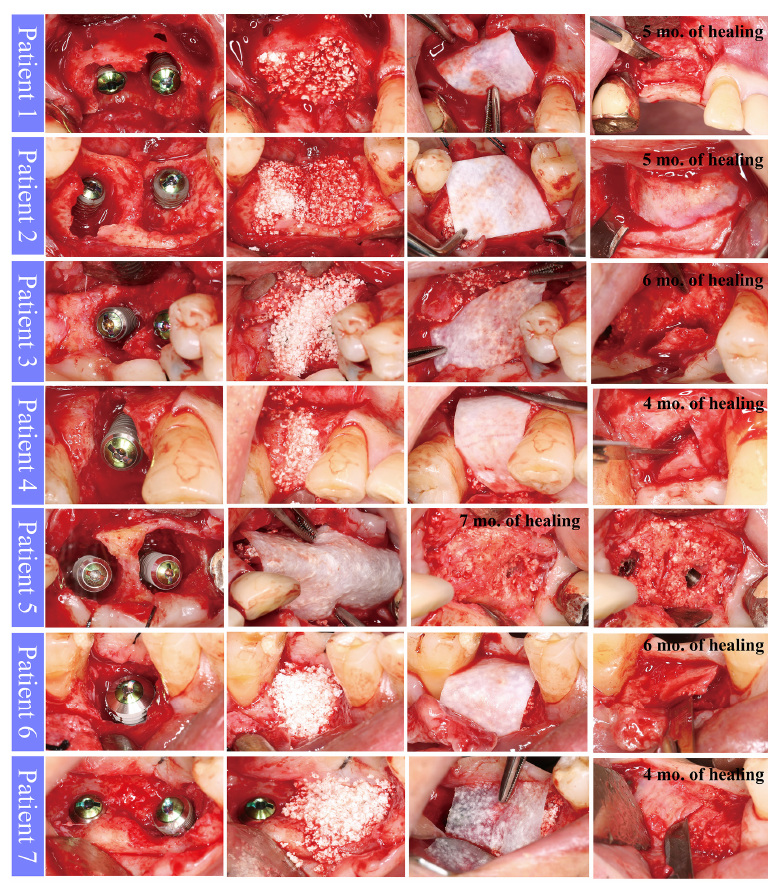
Figure 1. Representative clinical photographs of each case.